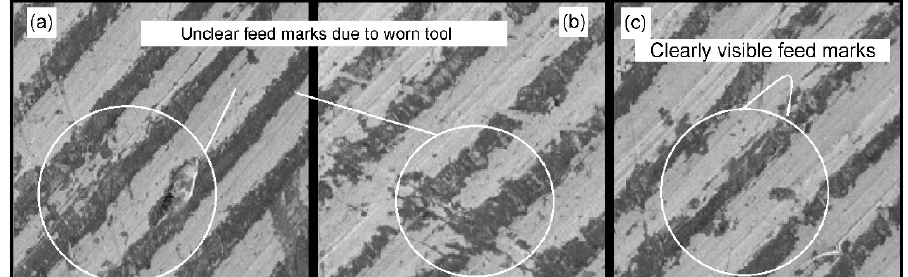
Fig. 9 Machined surface at cutting speed = 250 m/min, feed rate = 0.2 mm/rev, and approach angle = 75°: (a) Al 2 O 3 based nano-fluid, (b) MoS 2 based nano-fluid, and (c) graphite based nano-fluid. Reproduced with permission from Ref. [5], © Elsevier Ltd. 2016.